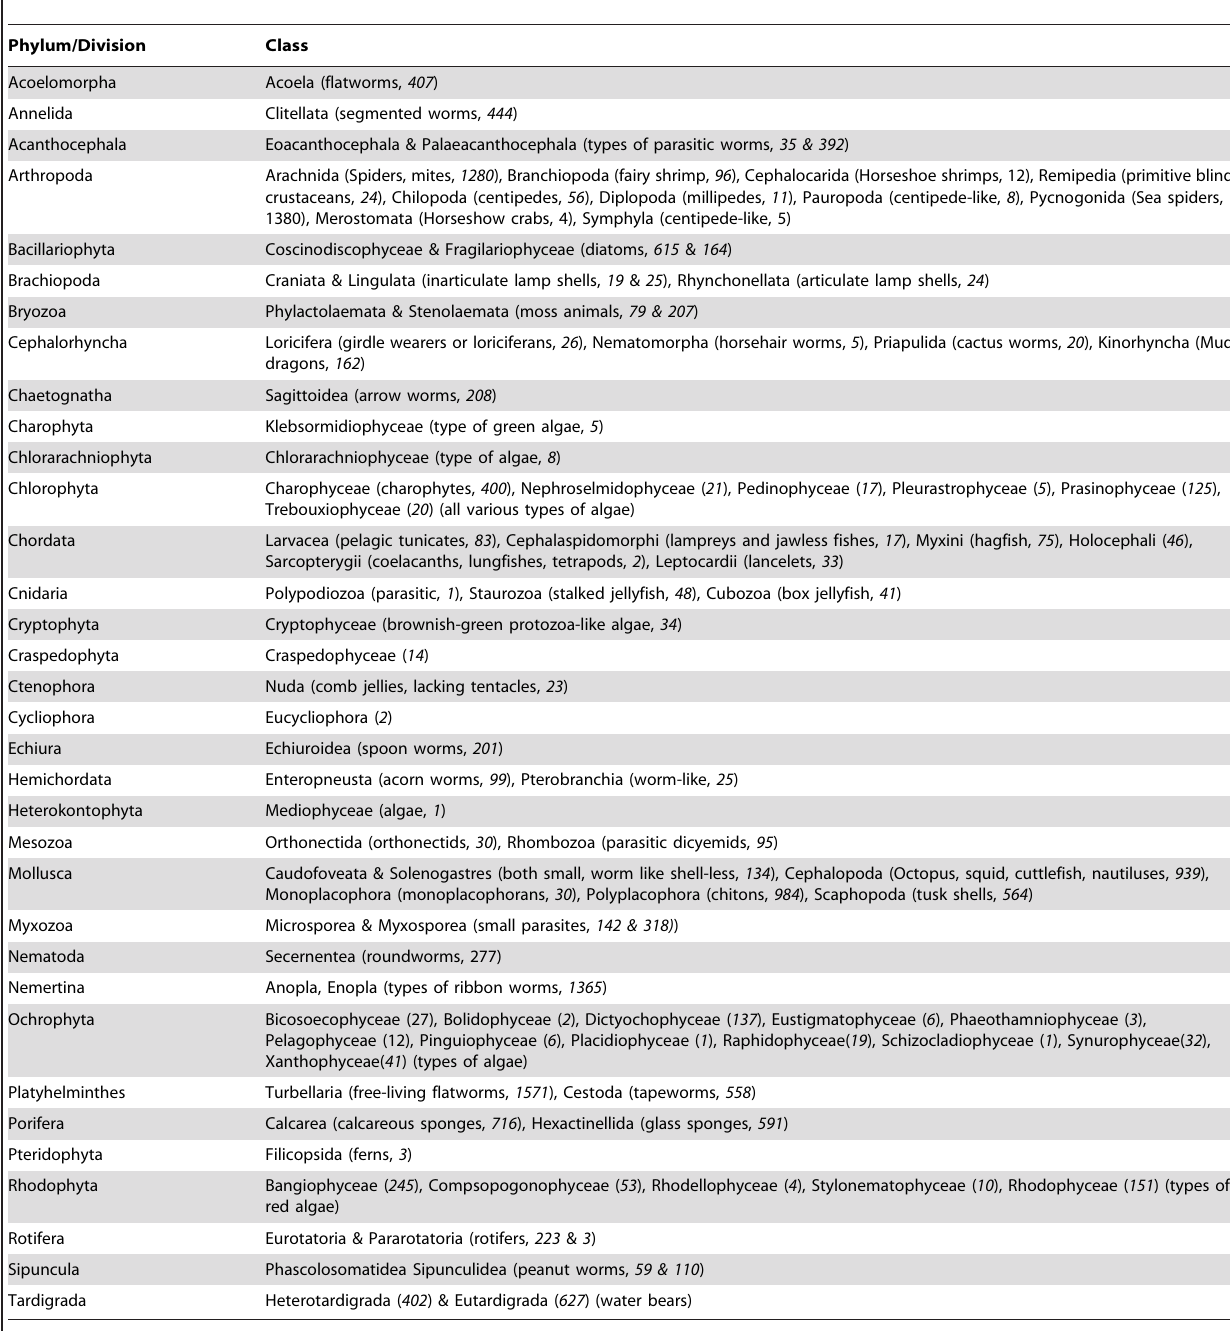
Table 3. Classes of marine Phyla (or Division) occurring in the World Registry of Marine Species (WoRMS) with less than 10 occurrences in the Web of Science H indexed literature for any of the four